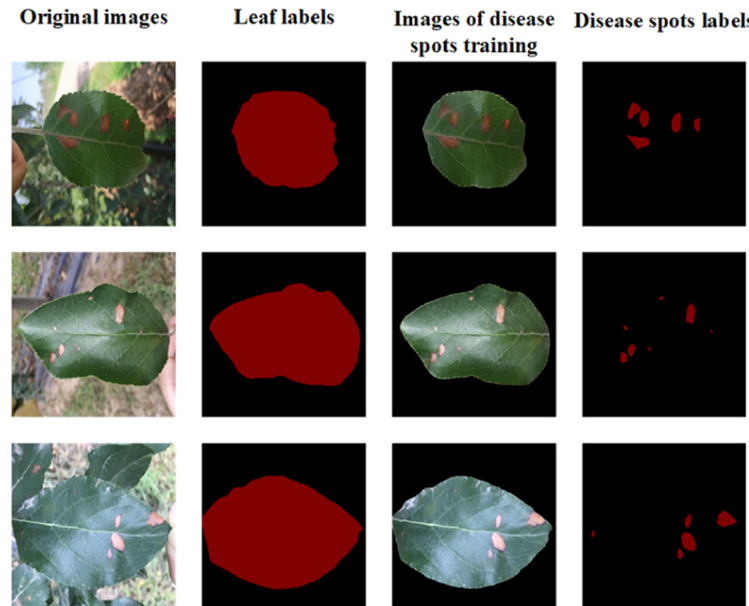
Figure 1. Results of labeling of leaves and disease spots.